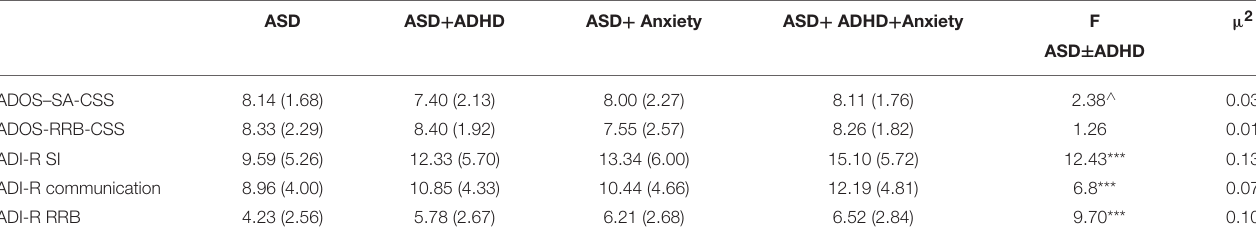
TABLE 4 | Mean scores and standard deviation of ADOS and ADI-R subdomains in the ASD alone, ASD + ADHD, ASD + anxiety, and ASD + ADHD + anxiety groups. ASD